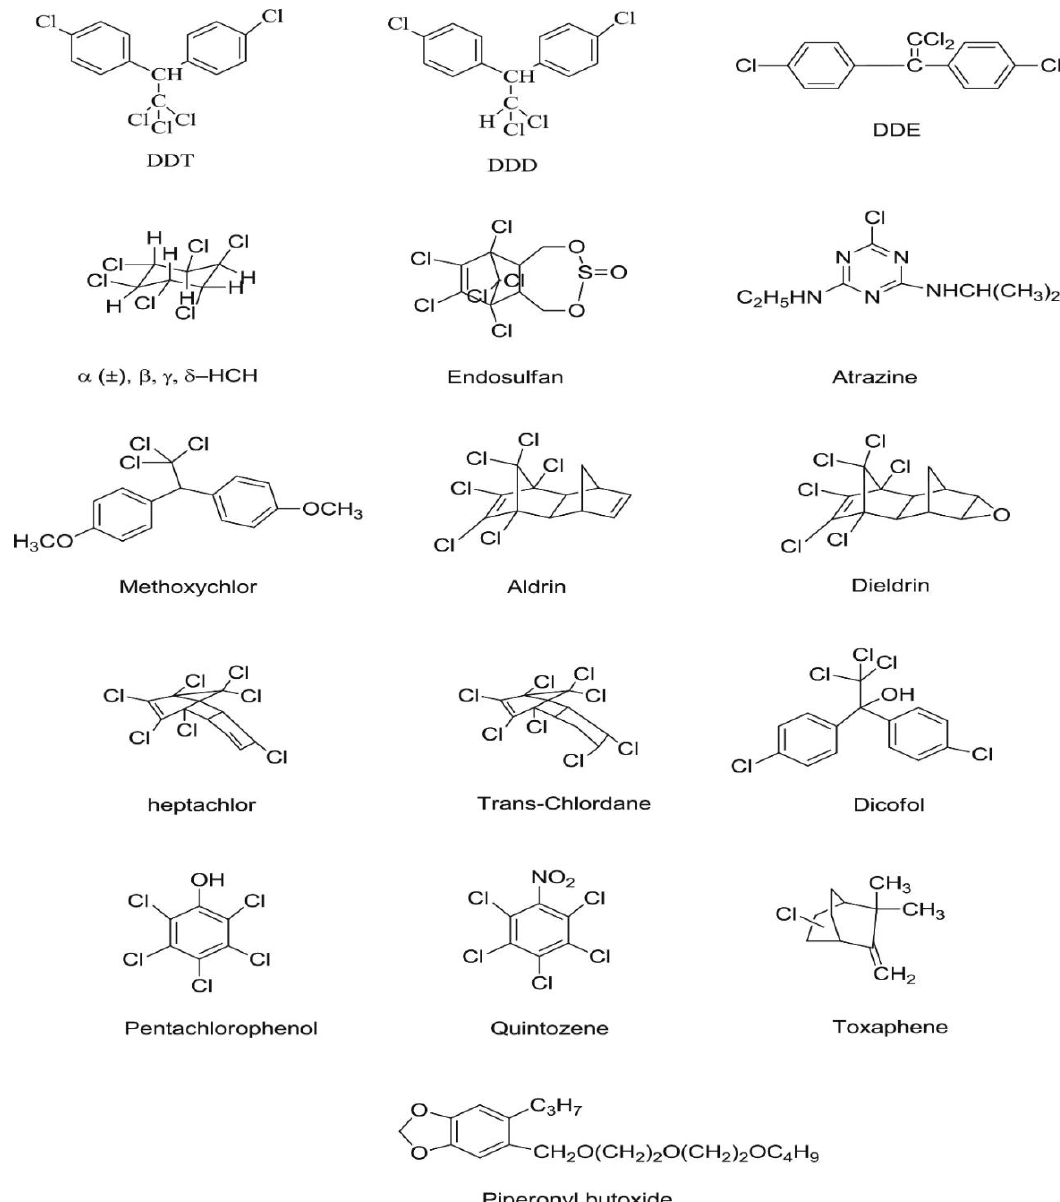
Figure 2. Structures of some organochlorine pesticides. Reprinted from [10]. Copyright (2017), with permission from Elsevier.